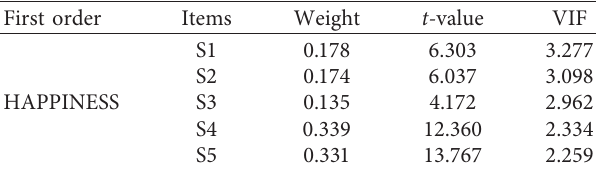
Table 4: Measurement model for the formative dimension. First order Items Weight t